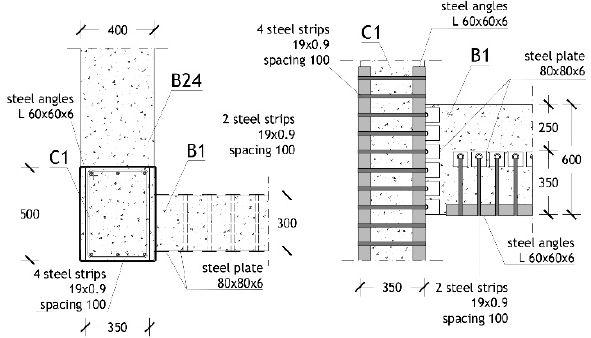
Figure 24. ACM-strengthened ground storey beam-to-column joint B.